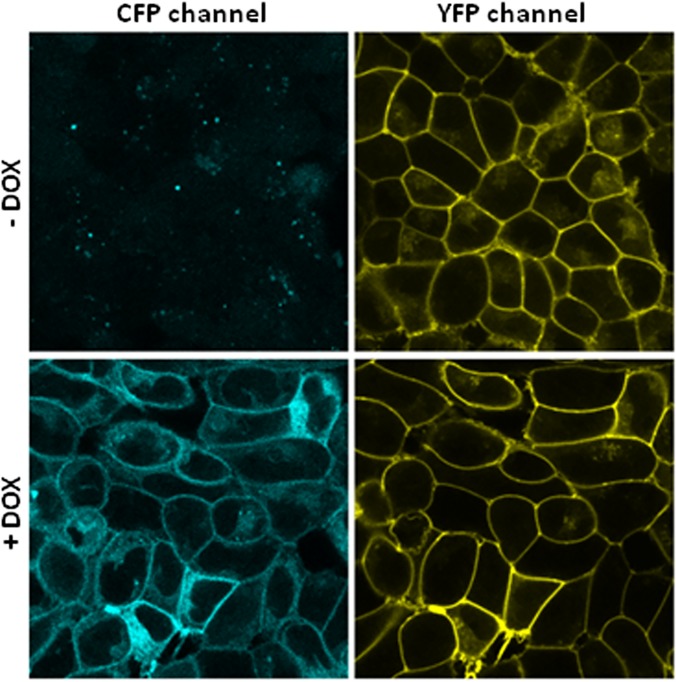
Generation of an inducible double-stable cell line expressing MOP-YFP and c-myc-5-HT2C-Cerulean receptors.Images obtained by confocal microscopy from living Flp-In HEK293 cells expressing permanently MOP-YFP receptors and c-myc-5-HT2C-Cerulean receptors in an inducible manner. The right column corresponds to the images resulting after exciting the cells with the YFP light settings whereas in the left column are the same microscopy field illuminated for CFP visualization. When indicated, +DOX corresponds to treatment with doxycycline (0.01 μg/ml) for 24 hours prior to microscope observation.